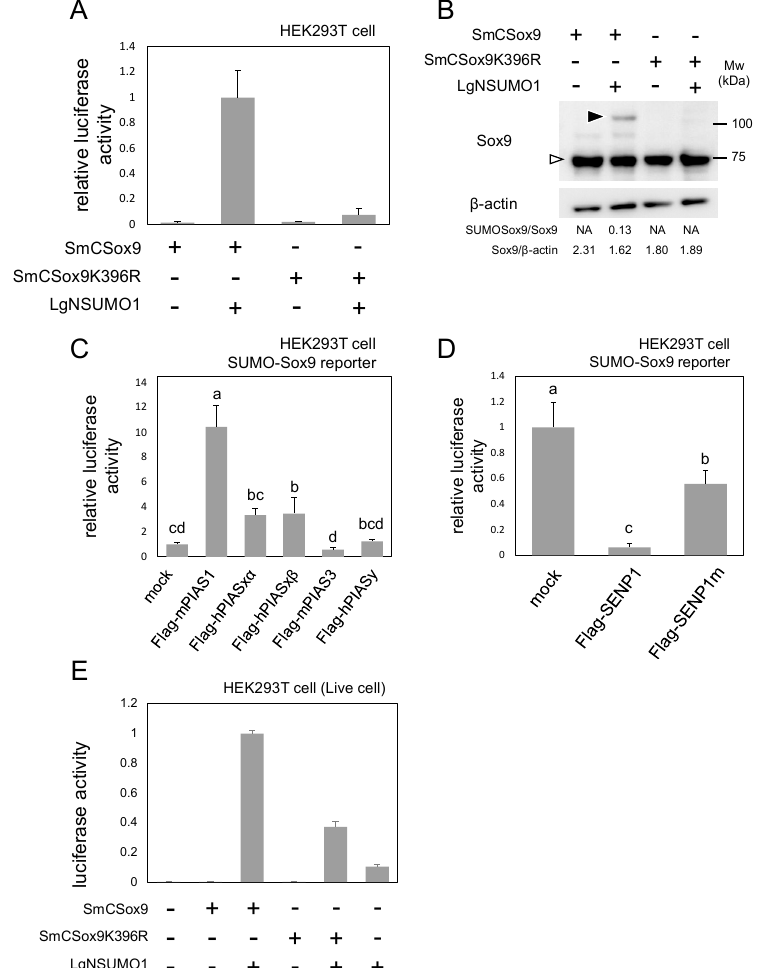
Figure 2. SUMO-Sox9 reporter activity in HEK293T cells. ( A ) A luciferase assay to examine the SUMOylation dependency of SUMO-Sox9 reporter. Bars indicate the mean value of triplicate wells. Error bars indicate the standard deviation. ( B ) Western blotting of the cell extract prepared as those of ( A ). White arrowhead indicates Sox9. Black arrowhead indicates SUMOylated Sox9. β -actin served as a loading control. The ratios of SUMOylated / non-SUMOylated Sox9 and non-SUMOylated Sox9 / ß-actin are shown at the bottom. NA indicates that one or both protein bands were not detected. ( C ) A luciferase assay to examine whether or not the SUMO-Sox9 reporter activity could be upregulated with the promotion of Sox9 SUMOylation. Bars indicate the mean value of triplicate wells. Error bars indicate the standard deviation. The mean values sharing a letter did not di ff er to a statistically significant extent ( p ≥ 0.05, Tukey’s HSD test). ( D ) A luciferase assay to examine whether or not the SUMO-Sox9 reporter activity could be downregulated with Sox9 deSUMOylation. The bars indicate the mean value of triplicate wells. Error bars indicate the standard deviation. The mean values sharing a letter did not di ff er to a statistically significant extent ( p ≥ 0.05, Tukey’s HSD test). ( E ) A luciferase assay to detect the SUMO-Sox9 reporter activity from live cells. Bars indicate the mean value of triplicate wells. Error bars indicate the standard deviation. All experiments were repeated at least twice, and representative results are